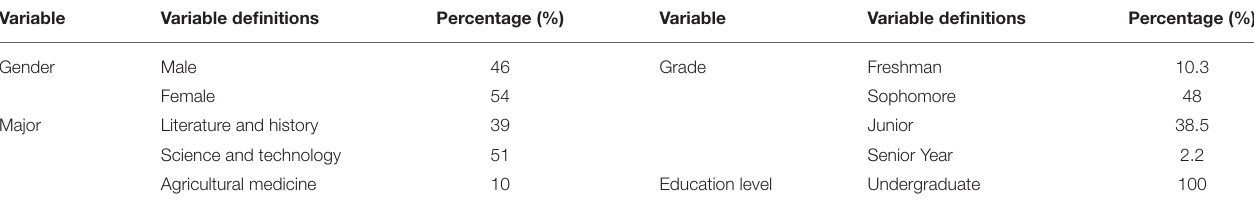
TABLE 2 | Participants’ demographic characteristics.